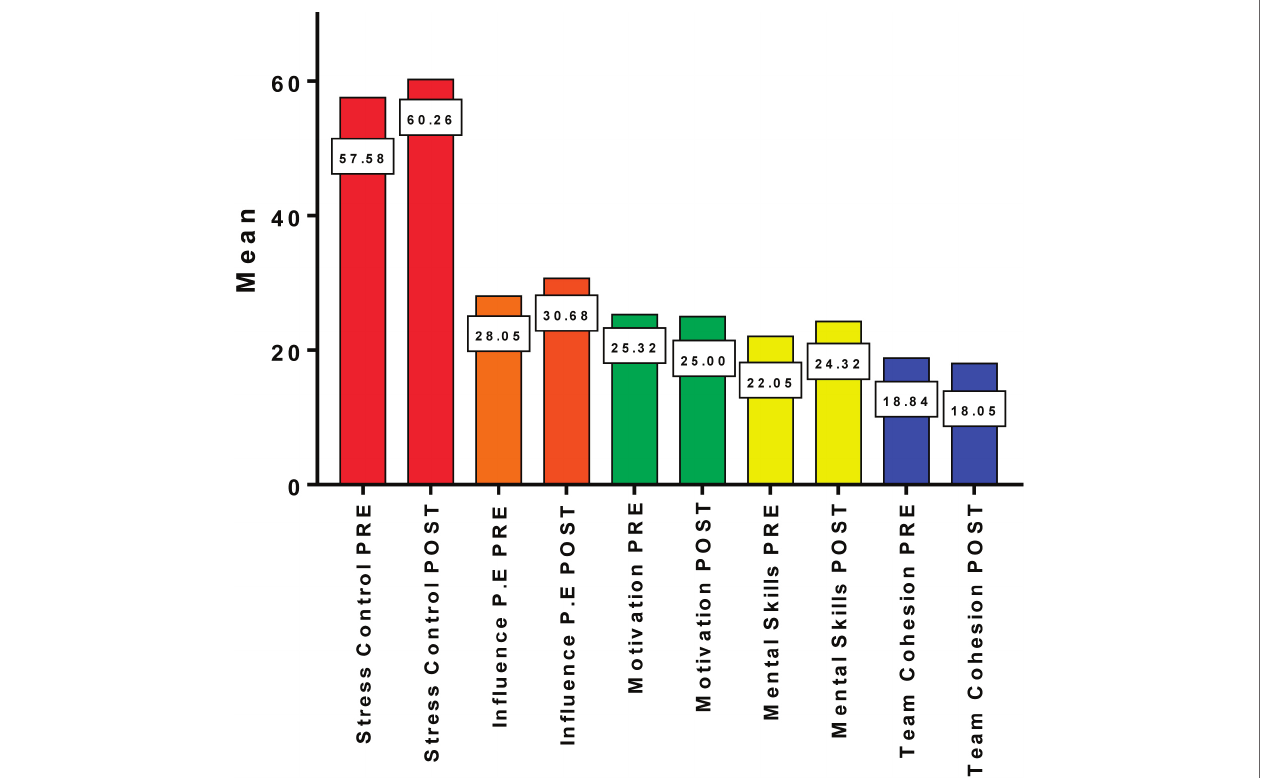
FIGURE 1 | Graphical comparison of the total means pre-test and